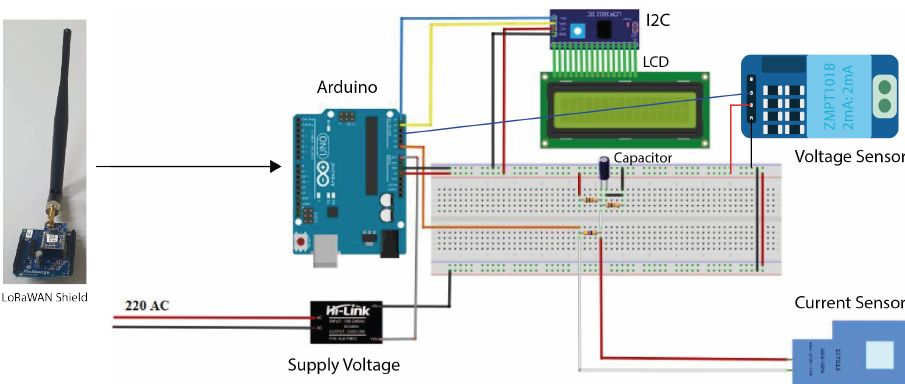
Figure 18. Manufacture of the Smart Meter electric